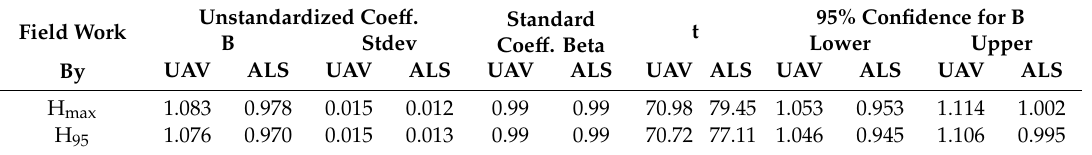
Table 8. Zero o ff set linear regression for tree heights measured using UAV, ALS, and